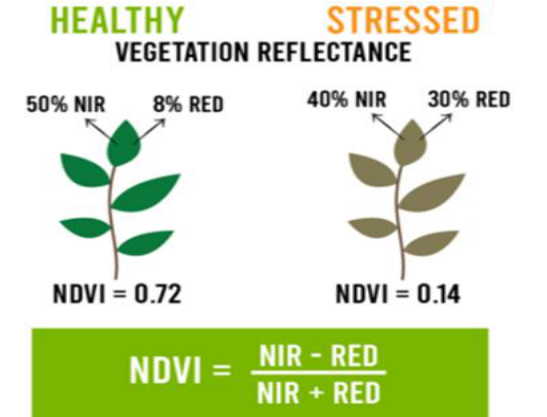
Figure 6. Plant analysis according to NDVI value.